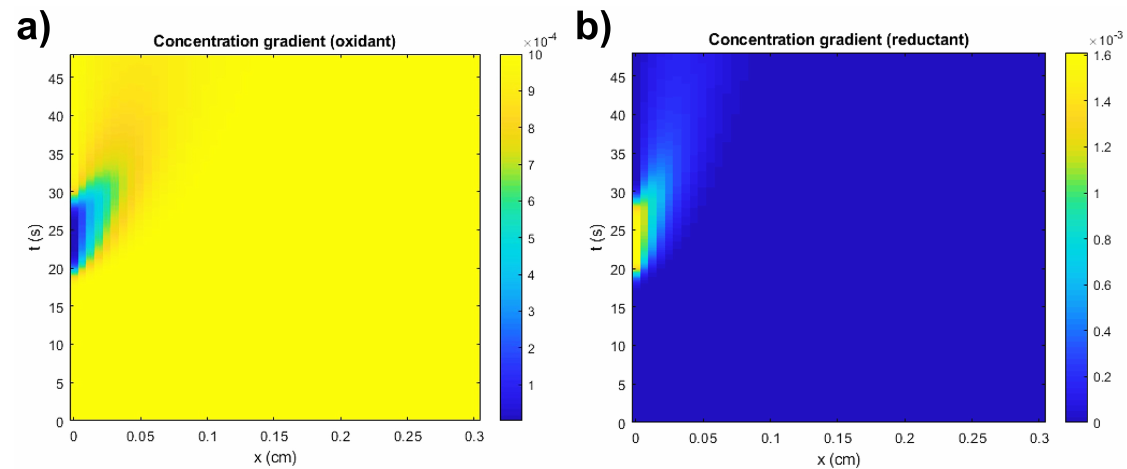
Figure 4. Simulated concentration gradients of ( a ) oxidant and ( b ) reductant. Figure 1. 1. This simulates the diffusion of oxidant molecules to the surface of the active material so that they oxidize to CoOOH (thus decreasing their concentration) and then are generated again when the active material is reduced back to Co(OH) 2 . It is a simple comprehensive way of observing how Butler–Volmer kinetics can demonstrate the electrochemical behavior of a redox couple such as Co(OH) 2 /CoOOH when combined with Fick’s 2nd Law of diffusion. The concentration gradient of the reductant occurs in a relatively analogous process to the oxidant, but with a contrary driving force. Considering the different diffusion coefficients that define the diffusion behavior of the electrolyte species, the gradients will differ slightly in the shape of the colored stain evidently visible. The gradients can be also displayed on the distance planes (Figure 5a,b).